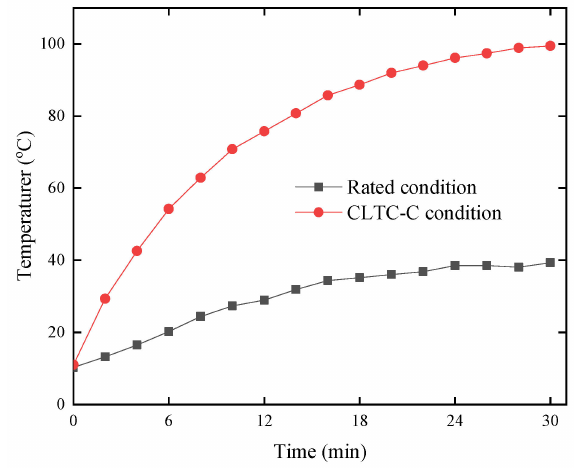
Figure 11. Temperature rise of the FSPM motor during